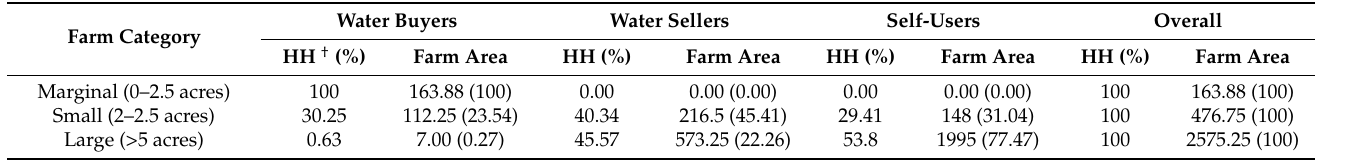
Table 2. Groundwater access and farmers’ area under different forms of water